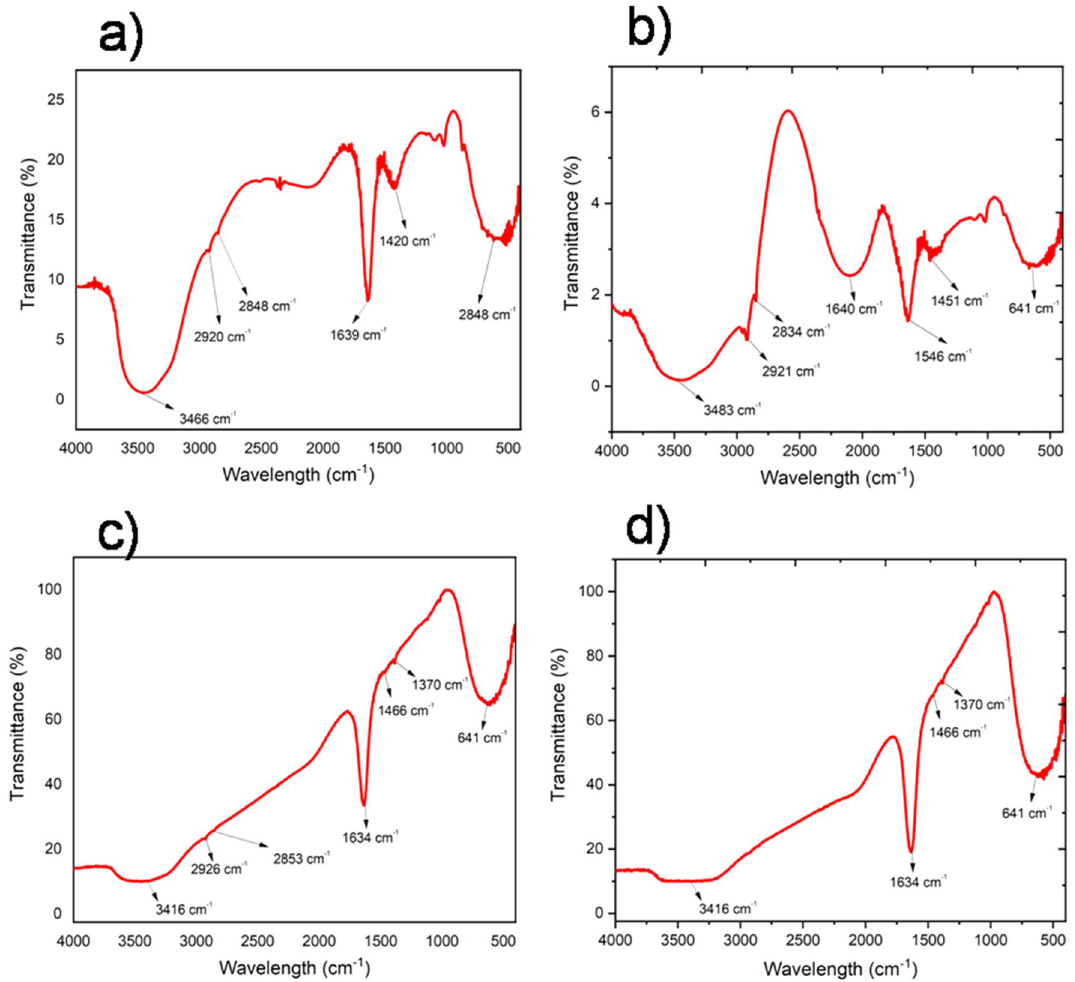
Figure. 4. FTIR spectroscopic analysis. ( a ) CTAC©AuNTs. ( b ) PSS@CTAC©AuNTs. ( c ) TPP-CTAC©AuNTs. ( d )